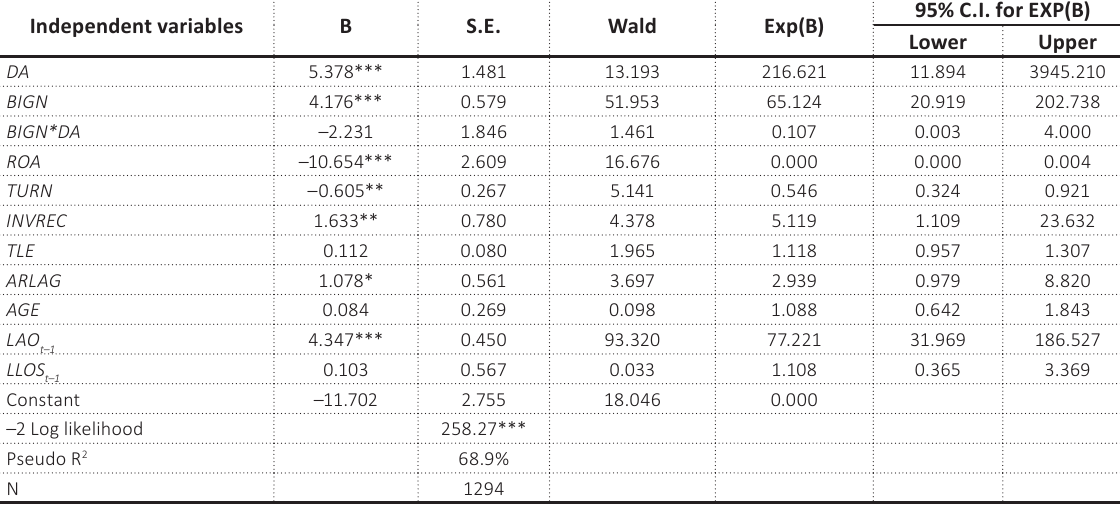
Table 5. Logistic regression results with the moderator variable (BIGN) Independent